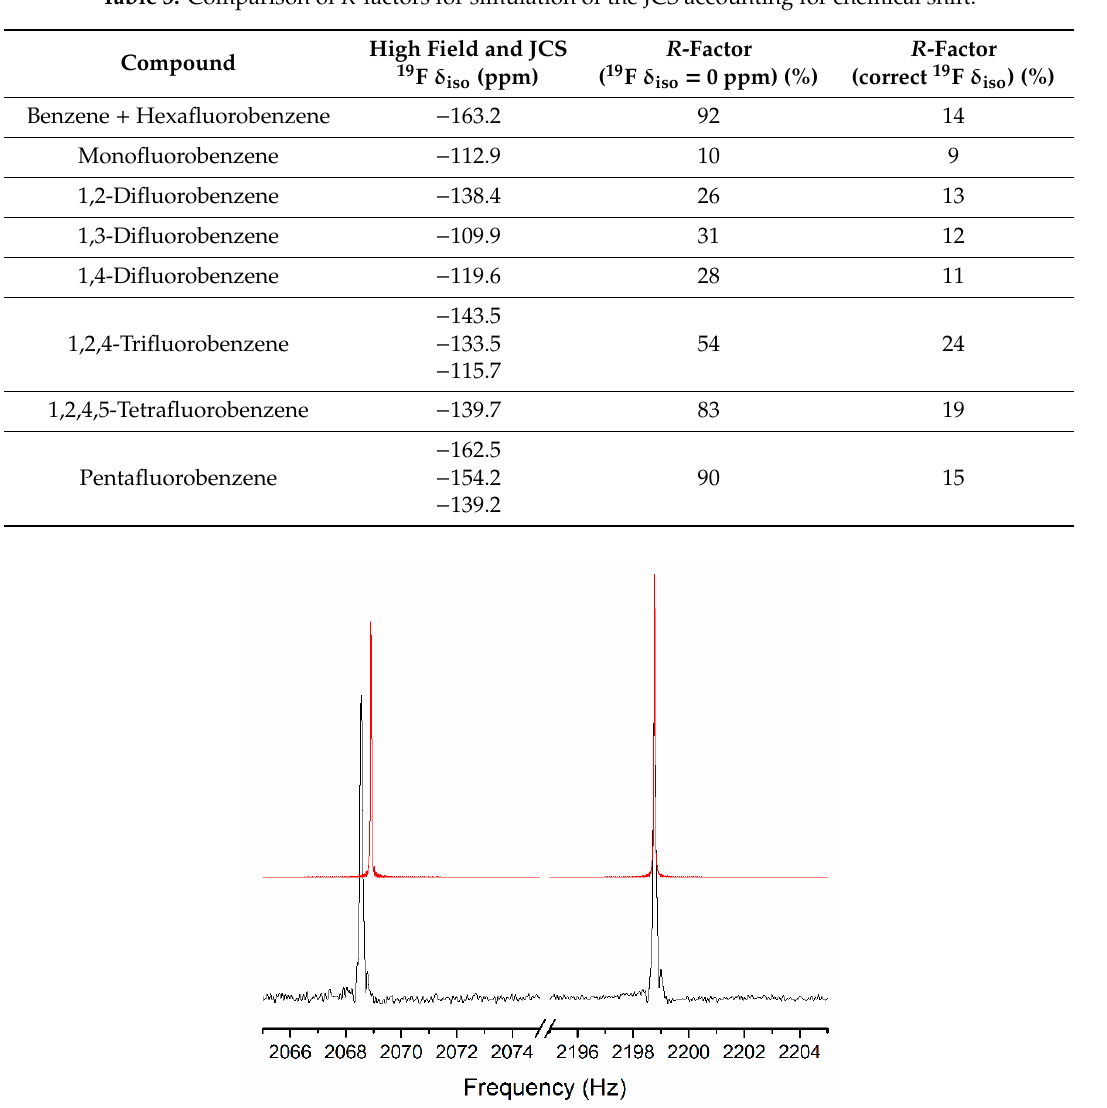
Figure 7. Impact of chemical shift on the simulated spectrum of a hexafluorobenzene + benzene mixture (1:1). The red spectrum is the simulated spectrum assuming 19 F δ iso = 0 ppm. The black spectrum is the experimentally acquired JCS, which was well fitted in simulations with a δ iso = − 163.2 ppm (Figure 3a). The hexafluorobenzene chemical shift at these microtesla ( µ T) fields is a discernable shift of approximately − 0.34